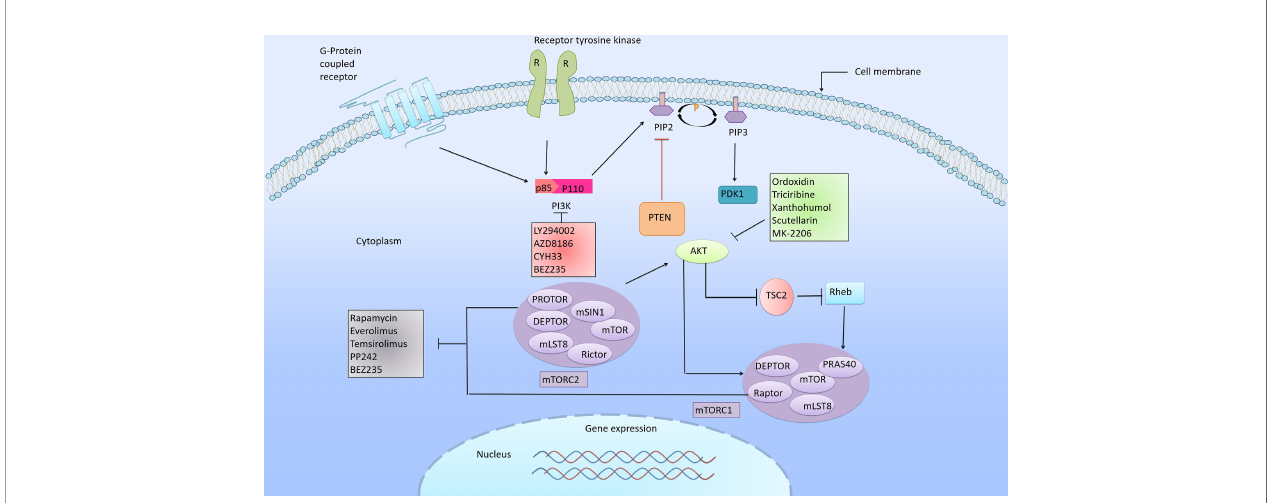
FIGURE 2 | PI3K/Akt/mTOR signaling cascade and its corresponding inhibitors. The PI3K/Akt/mTOR pathway is one of the most frequently altered pathways in cancer, and plays an important role in the regulation of cell growth, differentiation, proliferation, apoptosis and metastasis. Abnormal signal transduction in this pathway is closely related to the progression of cancer. Arrows indicate activation and bars indicate inhibition. The various inhibitors targeting PI3K/Akt/mTOR pathway proven to have inhibitory effects in